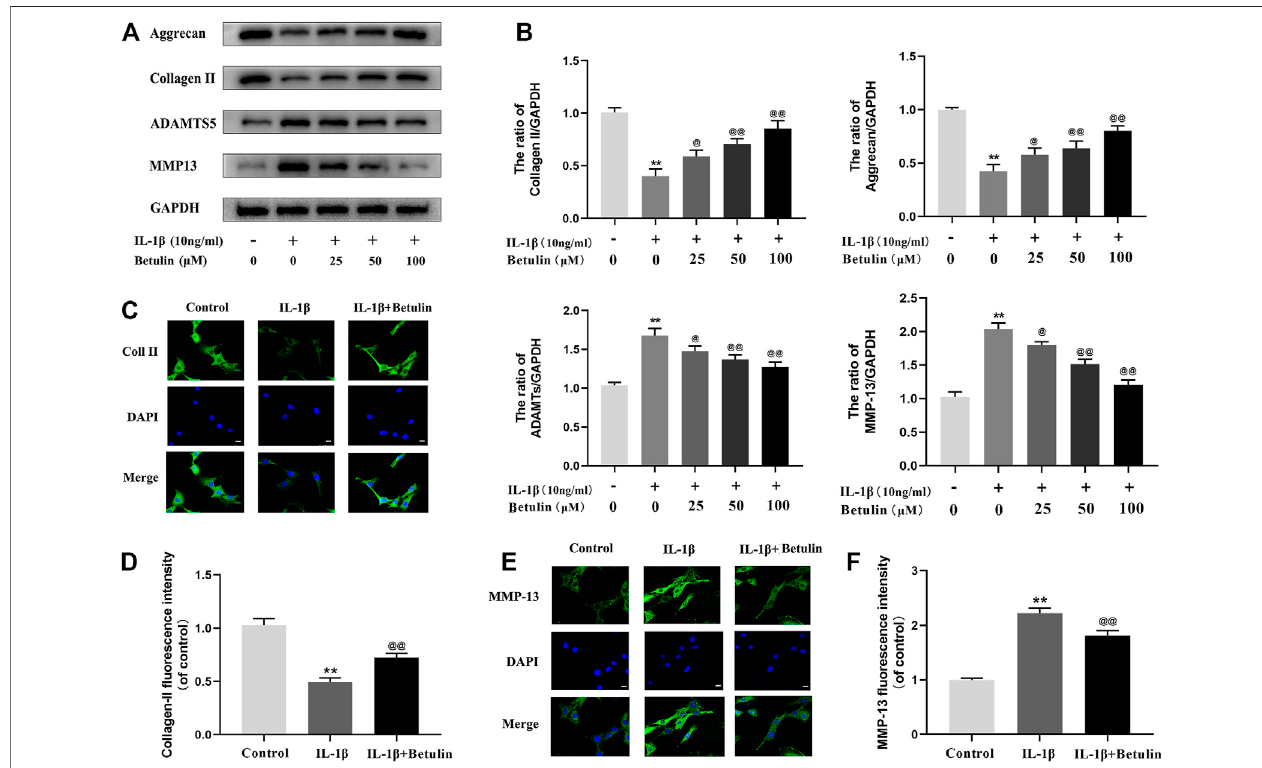
FIGURE 3 | Betulin treatment can inhibit the degradation of extracellular matrix. OA chondrocytes were cultured with betulin (0, 25, 50, and 100 μ M) of different concentrations for 2 h, followed by stimulation with or without IL-1 β (10 ng/ml) for 24 h. (A – B) The protein expression levels of Collagen II, Aggrecan, MMP13, and ADAMTS-5 were detected by Western blot and quantitatively analyzed. (C – F) Immuno fl uorescence staining combined with DAPI staining (scale: 25 μ m) was used to detect the fl uorescent expression of MMP13.The data in the fi gure are represented as the mean ± SD, ** p < 0.01 compared with the control group, @@ p < 0.01 compared with the IL-1 β group, n (cid:2)